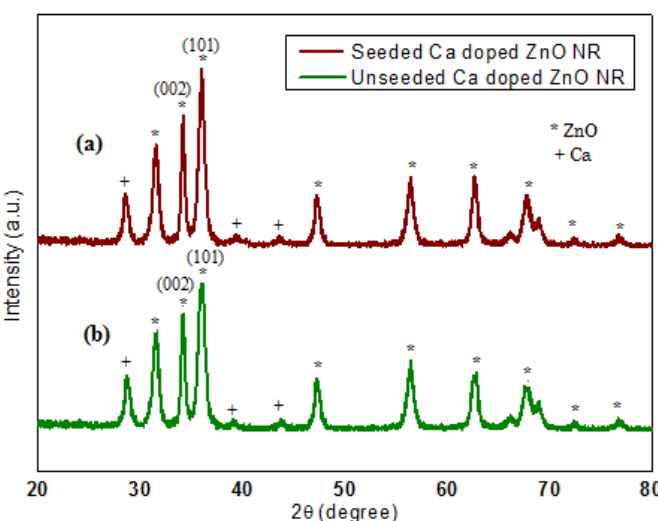
Figure 9. XRD graph of ( a ) Seeded Ca-doped ZnO NR and ( b ) Unseeded Ca-doped ZnO NR.